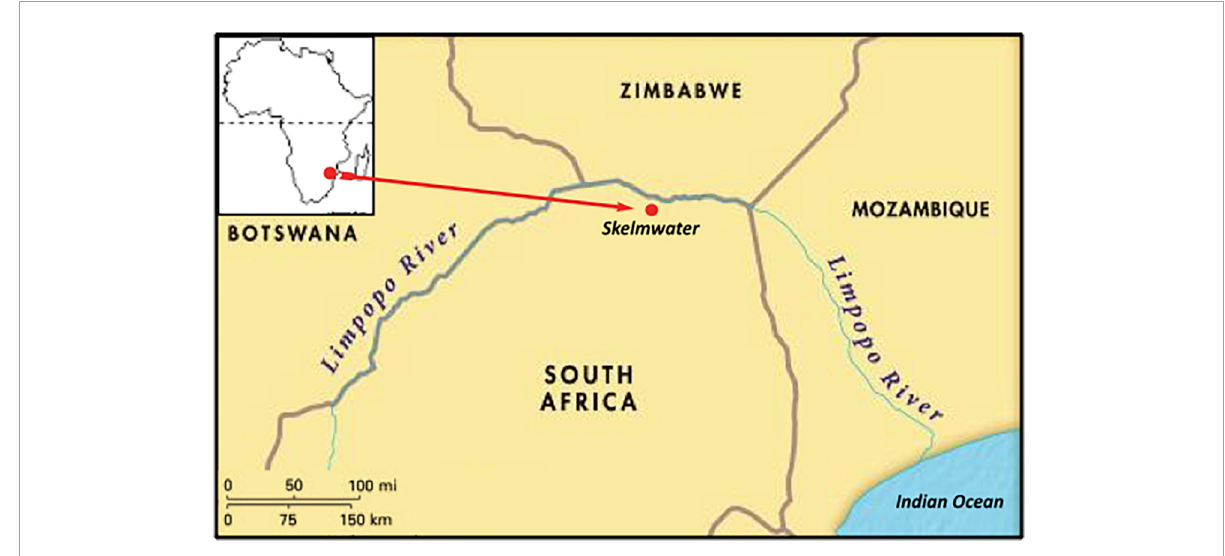
FIGURE1 Site location in the Limpopo River Valley and